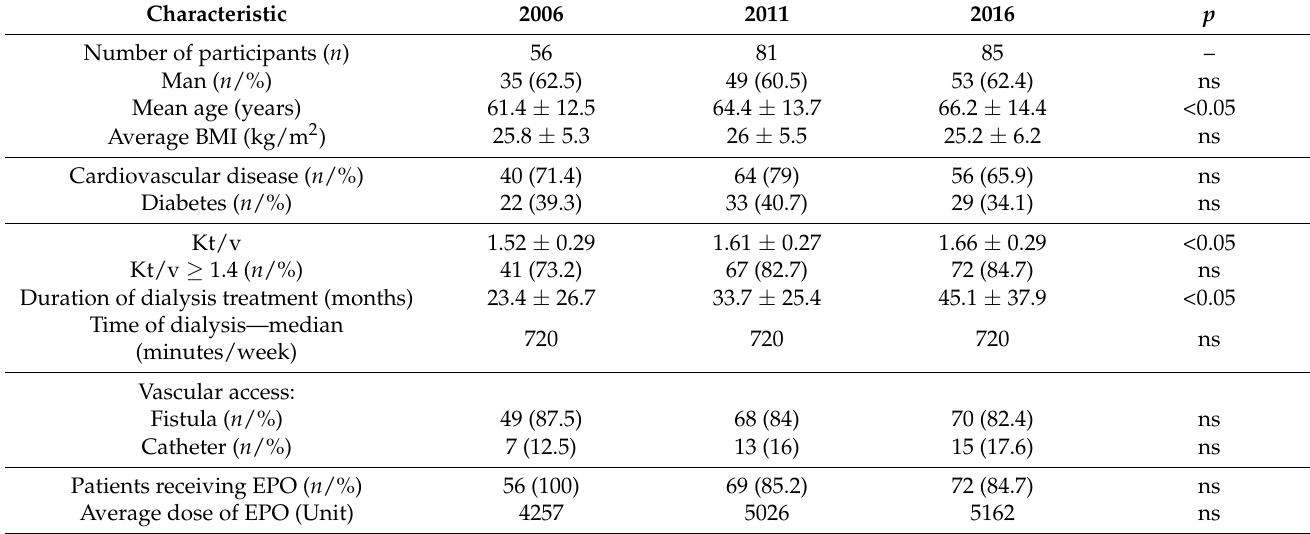
Table 1. Characteristic of the study population.